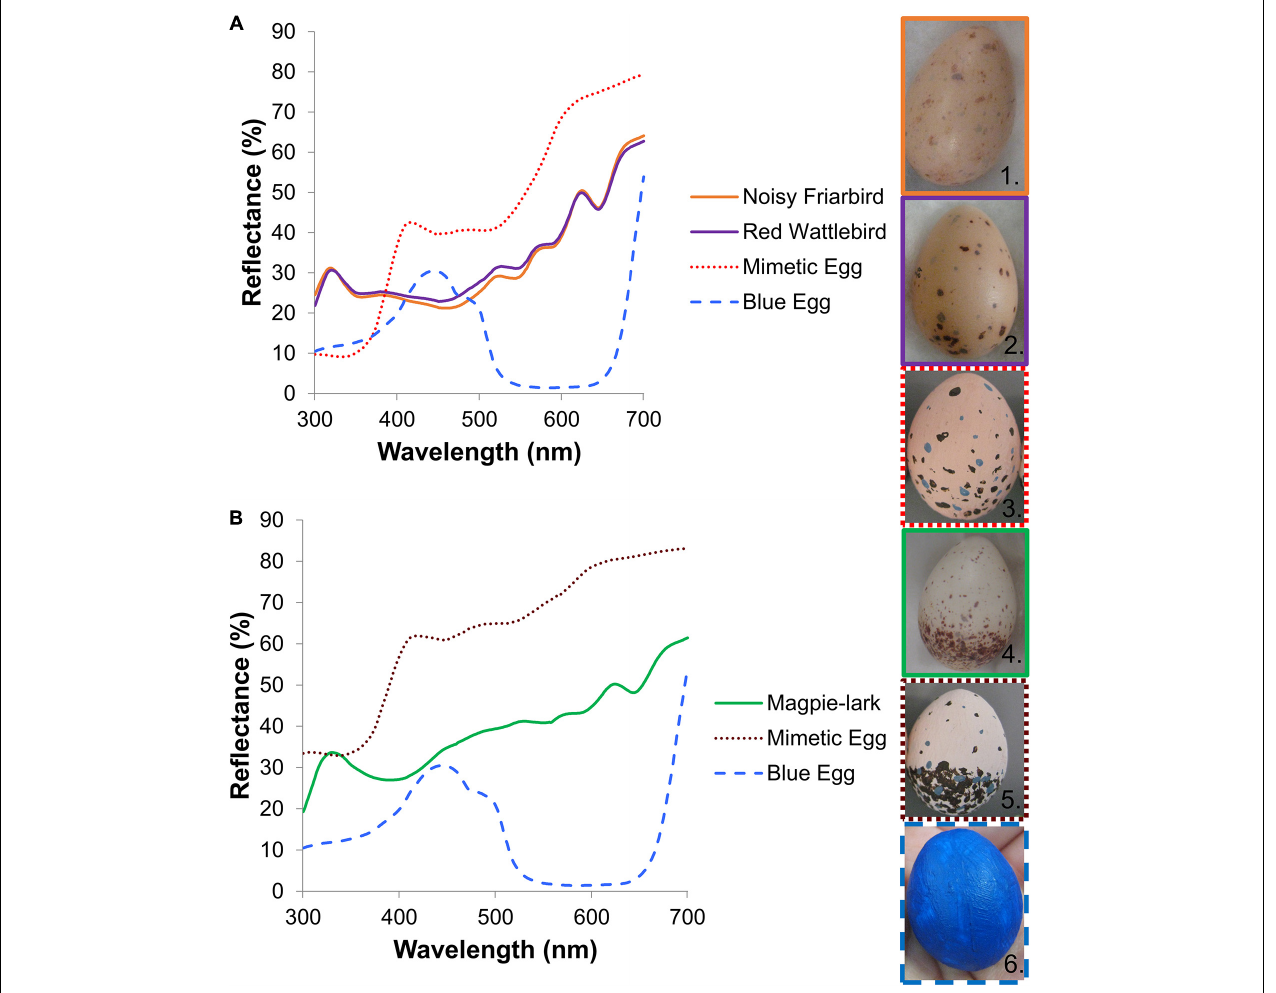
FIGURE 1 | (A) Average spectral reflectance of fresh Noisy Friarbird ( n = 13) and Red Wattlebird ( n = 45) clutches and their corresponding spotted model eggs ( n = 37) and blue eggs ( n = 10). (B) Average spectral reflectance of fresh Magpie-lark clutches ( n = 15), Magpie-lark spotted model eggs ( n = 21) and blue eggs ( n = 10). Images 1–6 are representative real host eggs and model eggs used in the egg ejection experiments: 1, Noisy Friarbird; 2, Red Wattlebird; 3, Wattlebird/friarbird spotted model; 4, Magpie-lark; 5, Magpie-lark spotted model; 6, Blue model. All photographs taken by V. E.